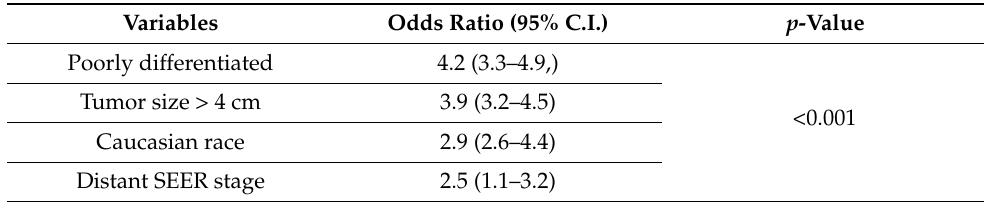
Table 6. Multivariable analysis of factors influencing mortality in patients with Primary Peritoneal mesothelioma from the Surveillance, Epidemiology, and End Results (SEER) database, 1975–2016. Variables Odds Ratio (95% C.I.) Poorly